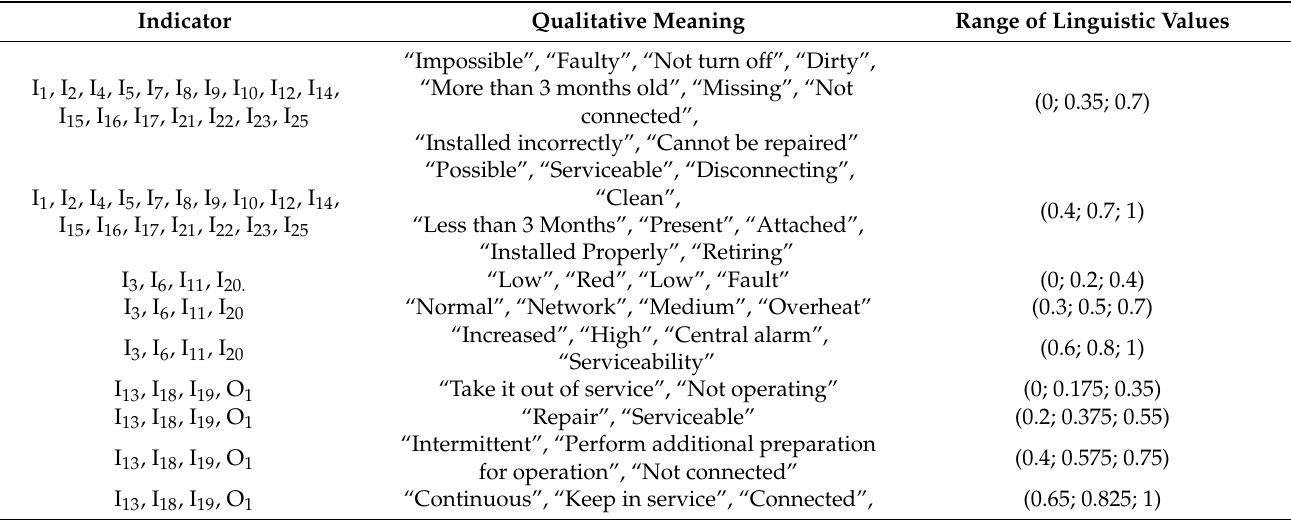
Table 3. Description of linguistic